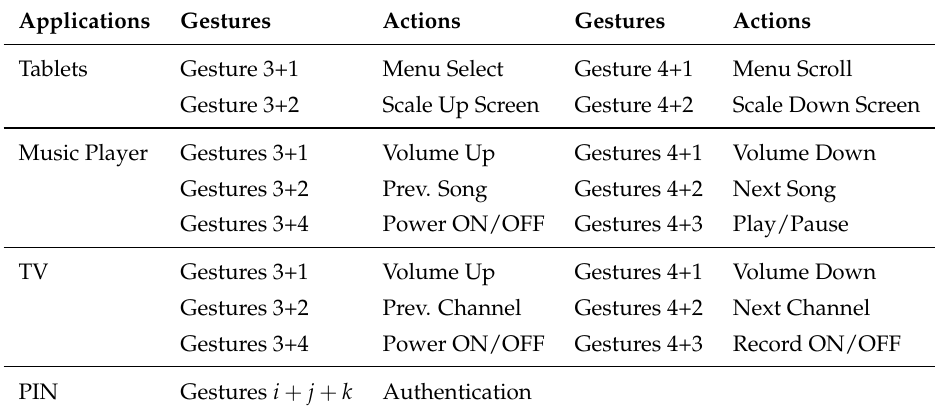
Table 4. Examples of the gestures and their actions for various remote control applications. Each sequence for device control contains two gestures. Each sequence as a personal identification number (PIN) for internet-of-things (IOT) appliances authentication contains three